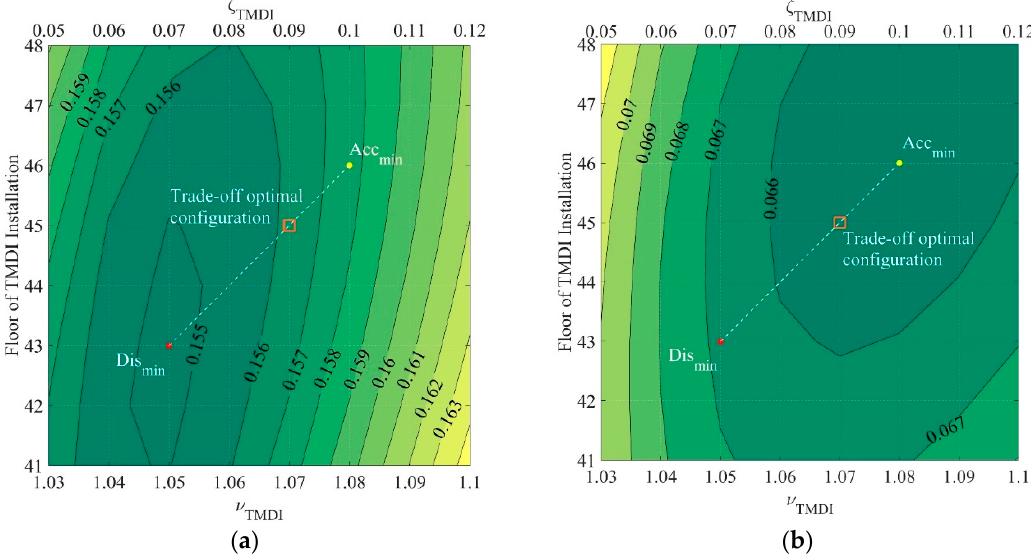
Figure 8. Contour of ( a ) peak displacement ( b ) peak acceleration with variable frequency ratio, damping ratio and floor of TMDI installation.